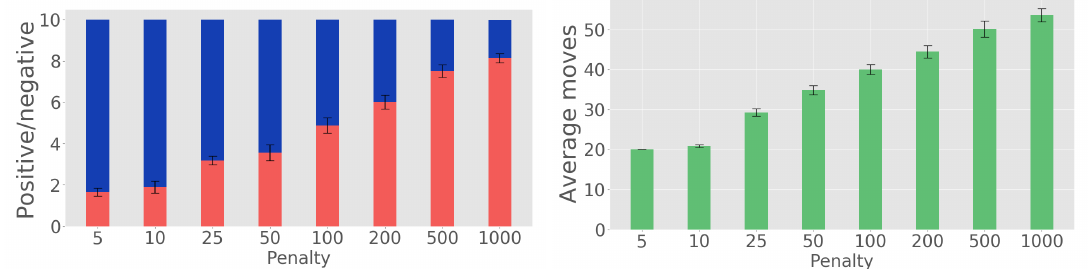
Figure 9. Single-position observations: Positives–negatives counts ( left ) and number of steps needed for sorting ( right